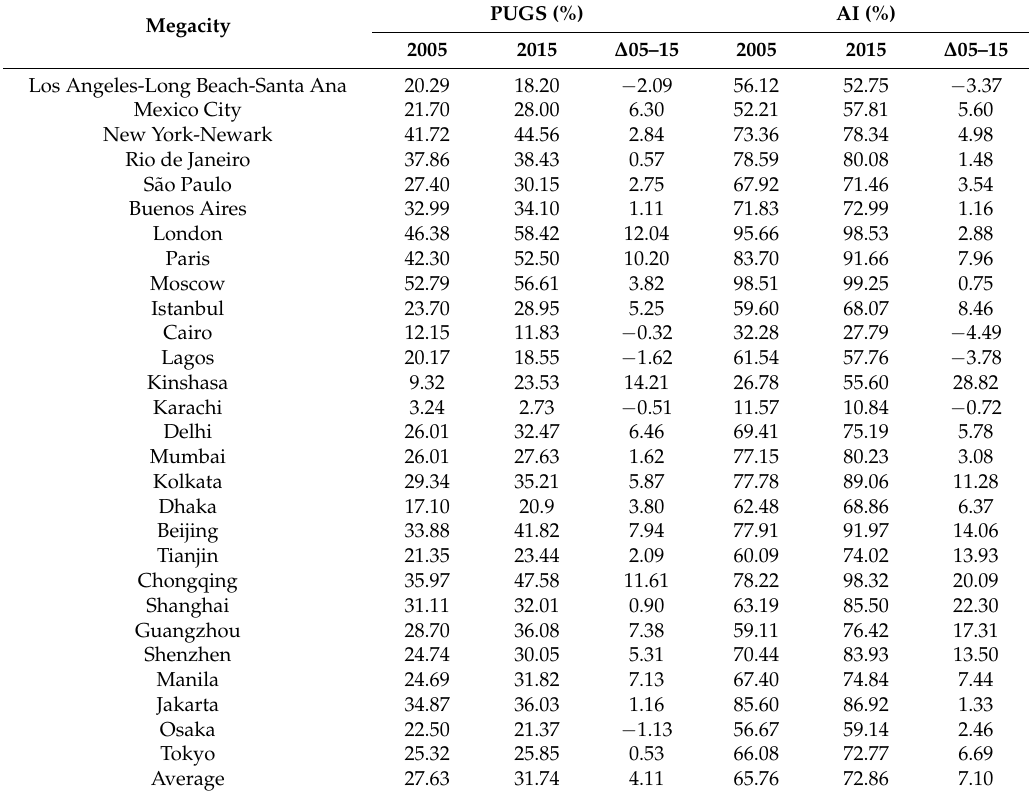
Table 3. Results of multiple general linear model regression for availability in 2005 and 2015. Factor